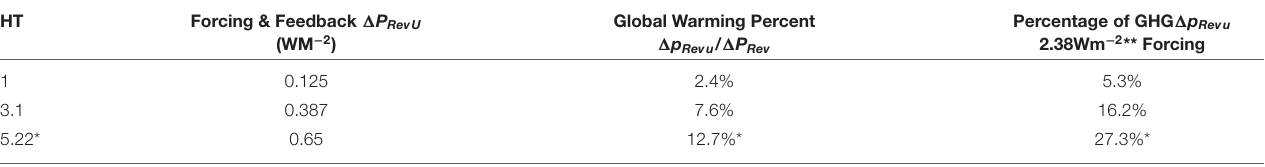
TABLE 2 | UHI Global warming estimates